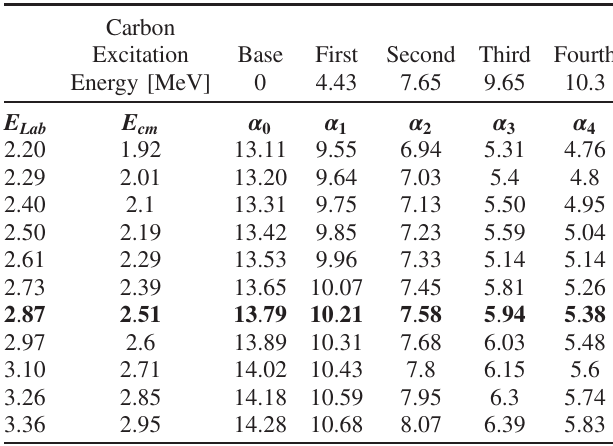
TABLE IV. Center of mass energies and the corresponding alpha energies for the different 12 C excitation levels for all deuteron beam energies ran in this experiment. The values in bold correspond to Fig. 10. Note: All energies are in MeV.